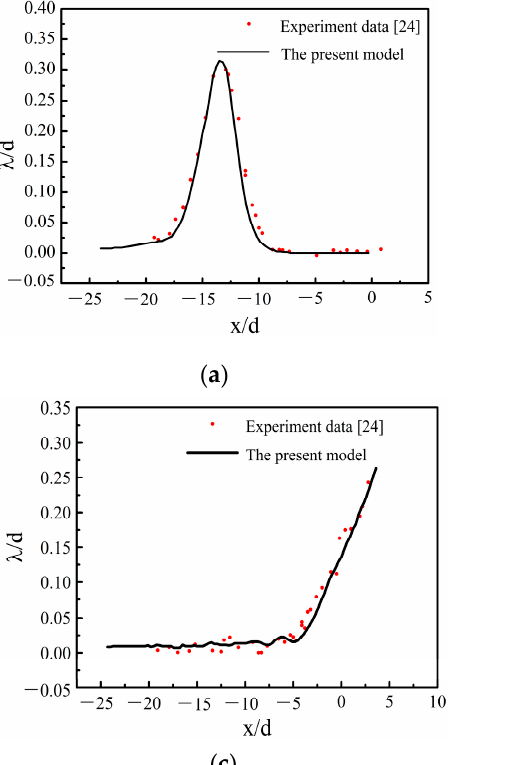
Table 1. Input parameters for parametric study.